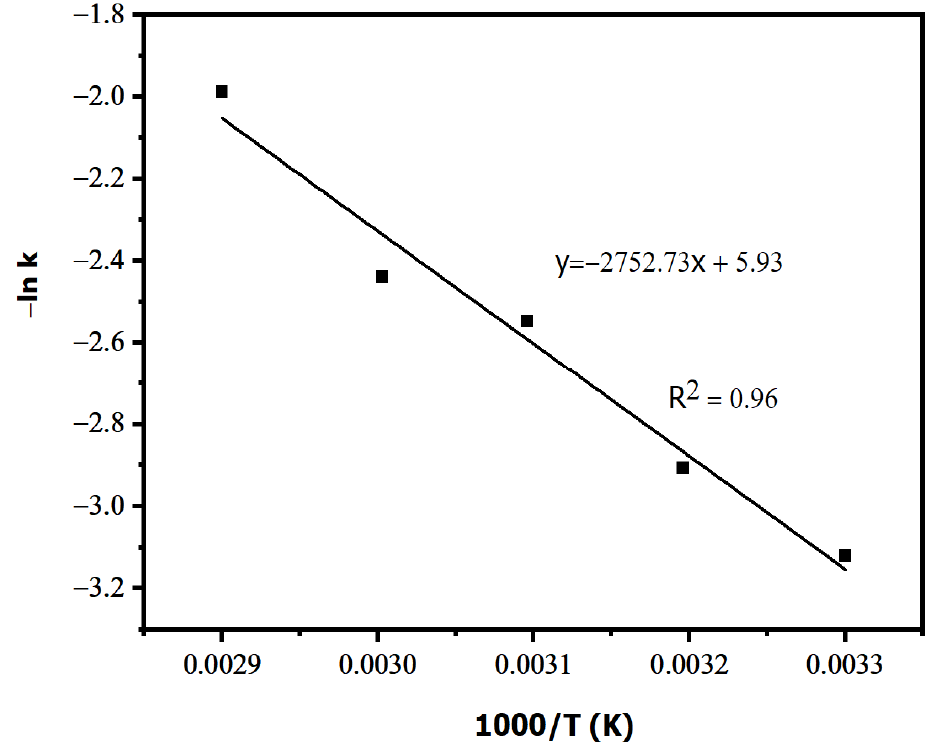
Figure 10. Arrhenius plot for the empirical kinetic model for gold.